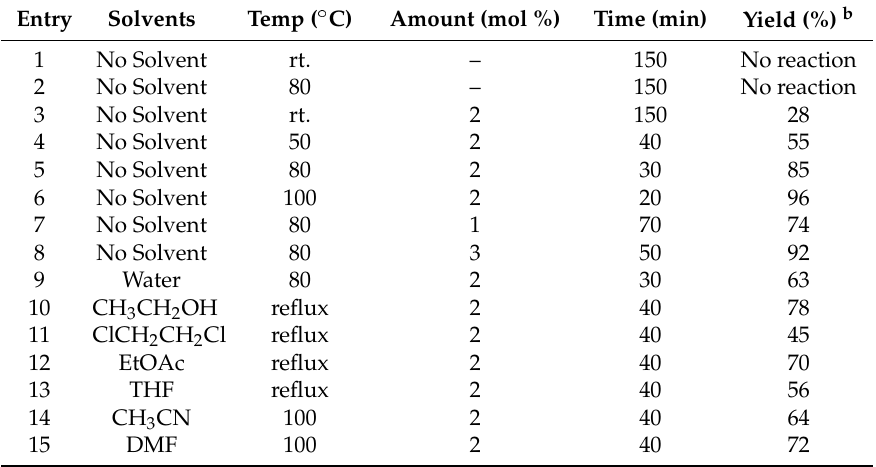
Table 1. Optimisation of reaction conditions for the synthesis of 5a a